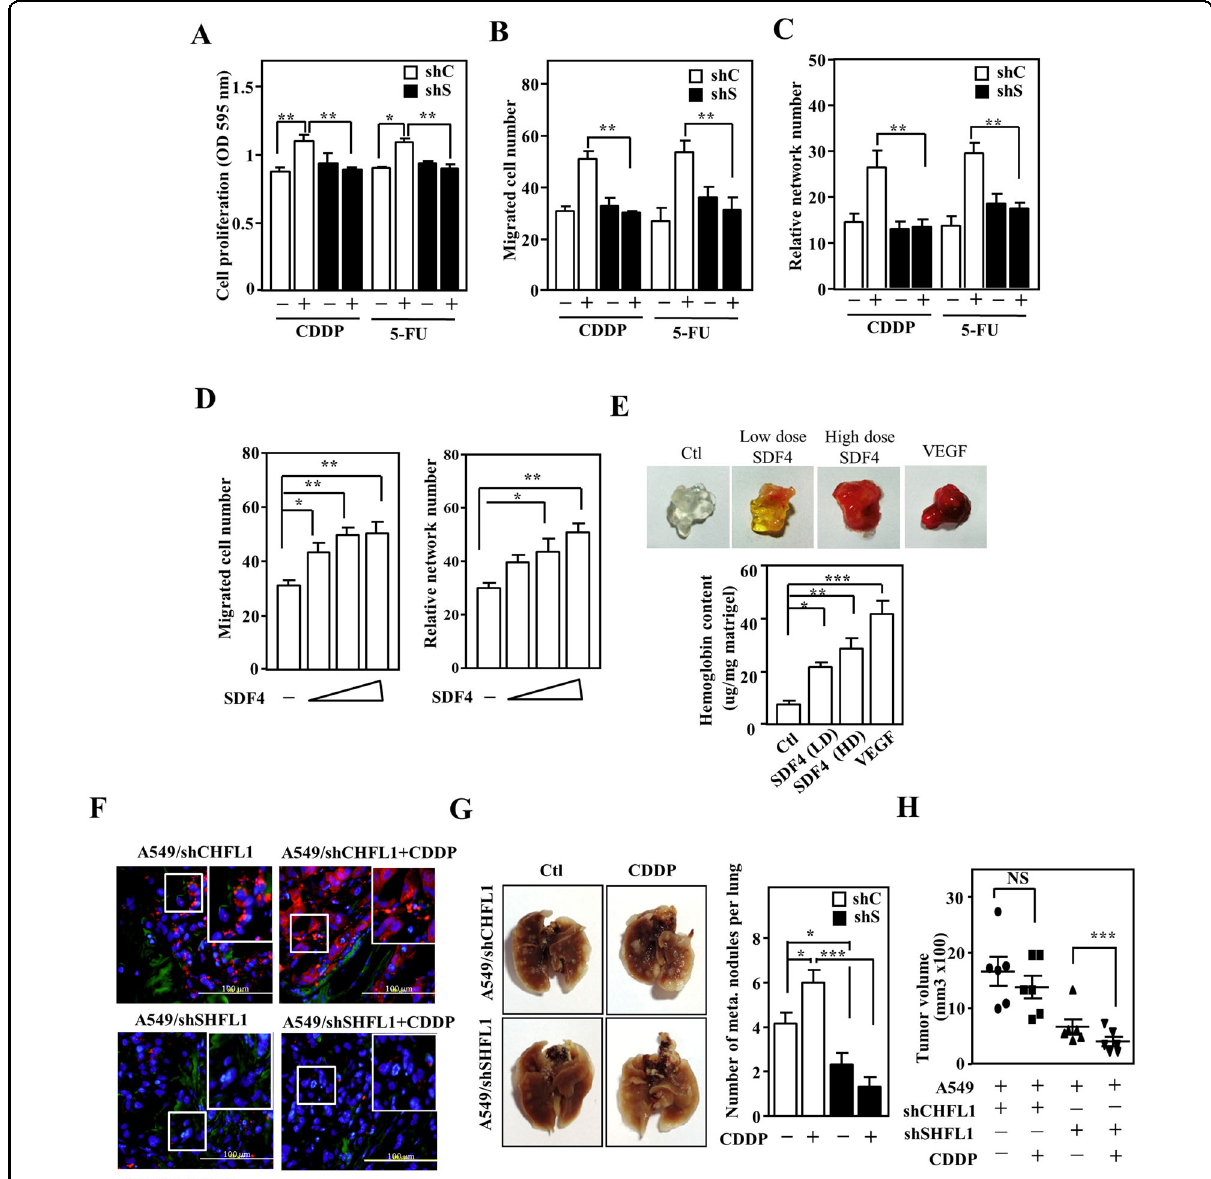
Fig. 4 SDF4 participates in proliferation, migration, and angiogenesis of endothelial cells. A The proliferation of HUVECs cultured in conditioned medium from HFL1 cells infected with sh β -galactosidase (shC) or shSDF4 (shS) lentiviruses and treated with or without CDDP or 5-FU for 6 h, followed by 18-h recovery with fresh medium was assessed. B The migration of HUVECs was assessed by determining the number of HUVECs cultured in conditioned medium from HFL1 cells infected with shC and shS lentiviruses and treated with or without CDDP or 5-FU for 6 h, followed by 18-h recovery with fresh medium. C Angiogenesis was assessed by counting the intersection number between branches of HUVECs growing in conditioned medium from HFL1 cells infected with shC and shS lentiviruses and treated with or without CDDP or 5-FU for 6 h, followed by 18 h recovery with fresh medium. D Assays to assess migration and in vitro tube formation were conducted as described in materials and methods. HUVECs were treated with SDF4 at 0.25, 0.5, and 1 μ g/ml. E Cebpd + / + (WT) mice were subcutaneously inoculated with 0.5- μ g/ml SDF4, 1- μ g/ml SDF4, or 0.2- μ g/ml VEGF Matrigel plugs. The experimental mice were sacri fi ced, and the Matrigel plugs were removed to assess the newly formed blood vessels; hemoglobin levels were measured in the plugs using a Drakin ’ s reagent kit ( n = 3 per group). VEGF was used as a positive control. F A549 cells mixed with HFL1 cells carrying a sh β -galactosidase knockdown vector with GFP (shC-GFP) or a SDF4 knockdown vector with GFP (shS-GFP) were inoculated subcutaneously into the dorsal rear fl anks of NOD-SCID mice, and the mice were treated with or without CDDP (5 mg/kg). The mice with A549-xenografted tumors were sacri fi ced in the 12th week. Tumor tissues were stained for CD31 (red) and GFP (green), and nuclei were stained with DAPI (blue). G The number of metastasis nodules from A549-xenografted tumors in the lungs was determined. H Tumor volume was measured with external calipers and calculated using the standard formula: V = ( w × l 2 ) × 0.52, where l is the length and w is the width of the tumor ( n = 6 per group). Three independent experiments were performed in triplicate. All data are expressed as the mean ± S.D. Differences among groups were analyzed with one-way ANOVA followed by the Tukey ’ s multiple comparison test. * p < 0.05, ** p < 0.01, *** p <